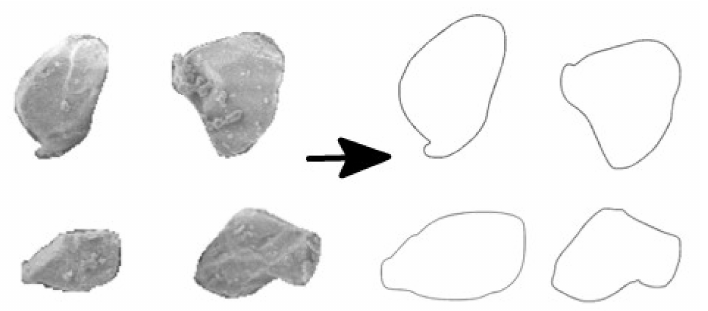
Figure 14. Schematic diagram of two-dimensional image processing of SF in two-dimensional scale.